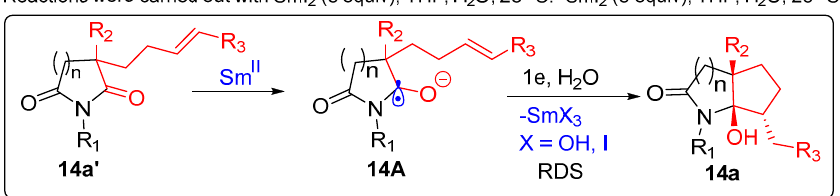
Scheme 14. Samarium ‐ mediated reductive desymmetrization of cyclic